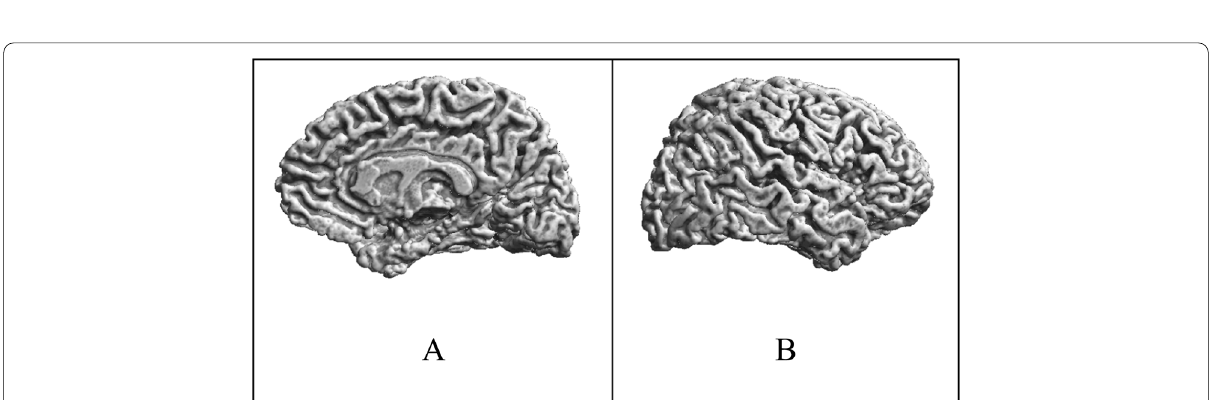
Fig. 4 Reconstructed surface by CAT12 toolbox. A Reconstruction of internal surface of right hemisphere surface of the brain. B Reconstruction of external surface of left hemisphere surface of the brain. (The reconstructed surface in the CAT12